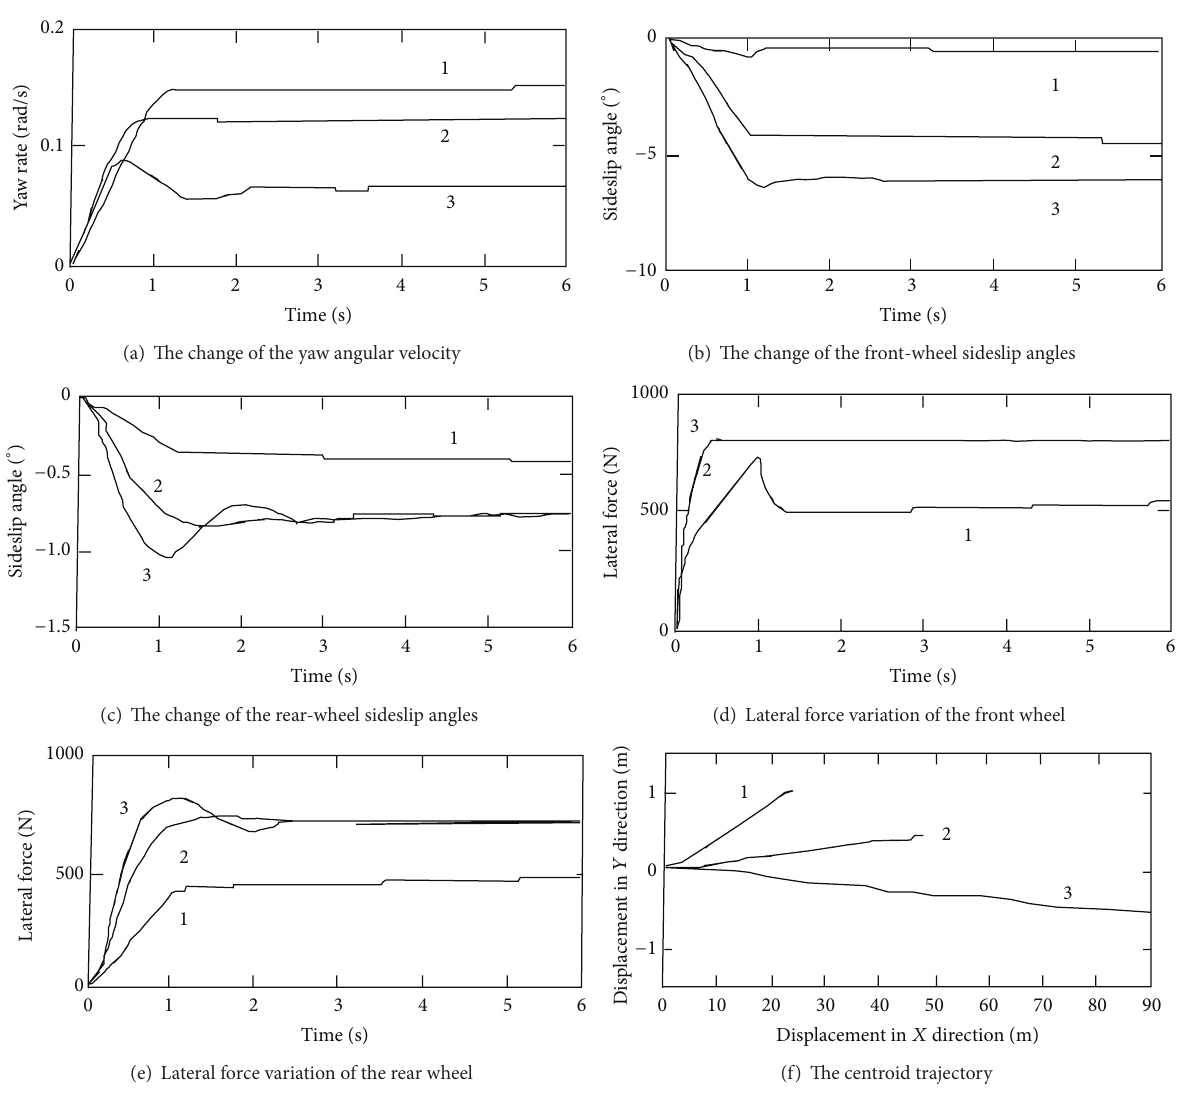
Figure 4: Characteristics of cars at different speeds on the low friction road. Curve 1: the speed is 14.4 km/h; Curve 2: the speed is 28.8 km/h; Curve 3: the speed is 54